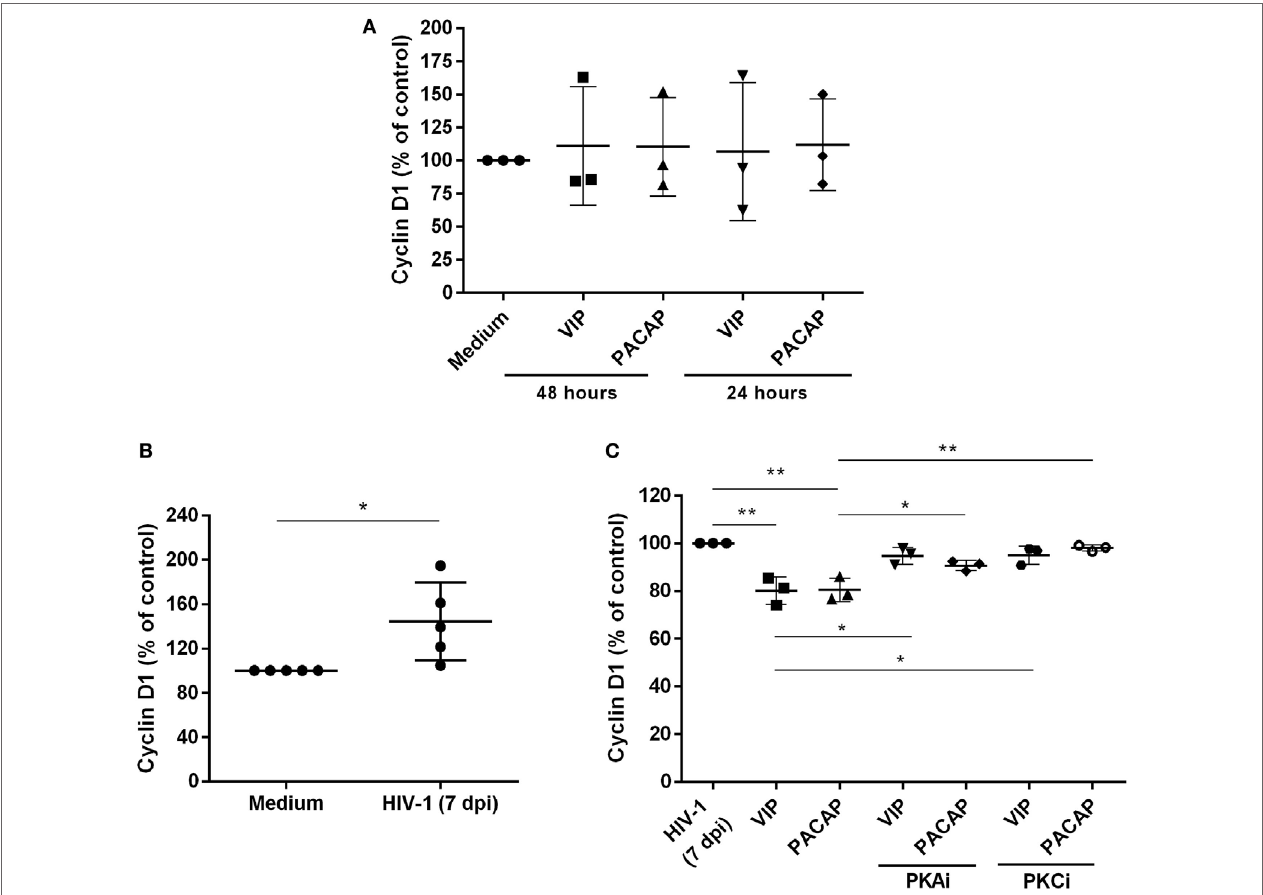
FigUre 6 | Vasoactive intestinal peptide (VIP) and pituitary adenylate cyclase-activating polypeptide (PACAP) reduce Cyclin D1 levels in HIV-1-infected macrophages. (a) Uninfected macrophages were exposed to VIP or PACAP (10 nM) and levels of total Cyclin D1 were quantified by ELISA 24 or 48 h later ( n = 3). (B) Macrophages were infected with HIV-1 and 7 days later the levels of Cyclin D1 were analyzed by ELISA ( n = 5). (c) Macrophages were treated with VIP or PACAP (10 nM) 7 days after HIV-1 infection (7 dpi), in the presence or not of protein kinases A (PKA) or C (PKC) inhibitors (PKAi, H89; PKCi, Gö 6983; 50 nM each one, for 30 min; cells were washed before neuropeptide addition), and levels of Cyclin D1 were quantified by ELISA 24 h later ( n = 3). * p < 0.05; ** p < 0.01; one-way ANOVA, with Dunnett